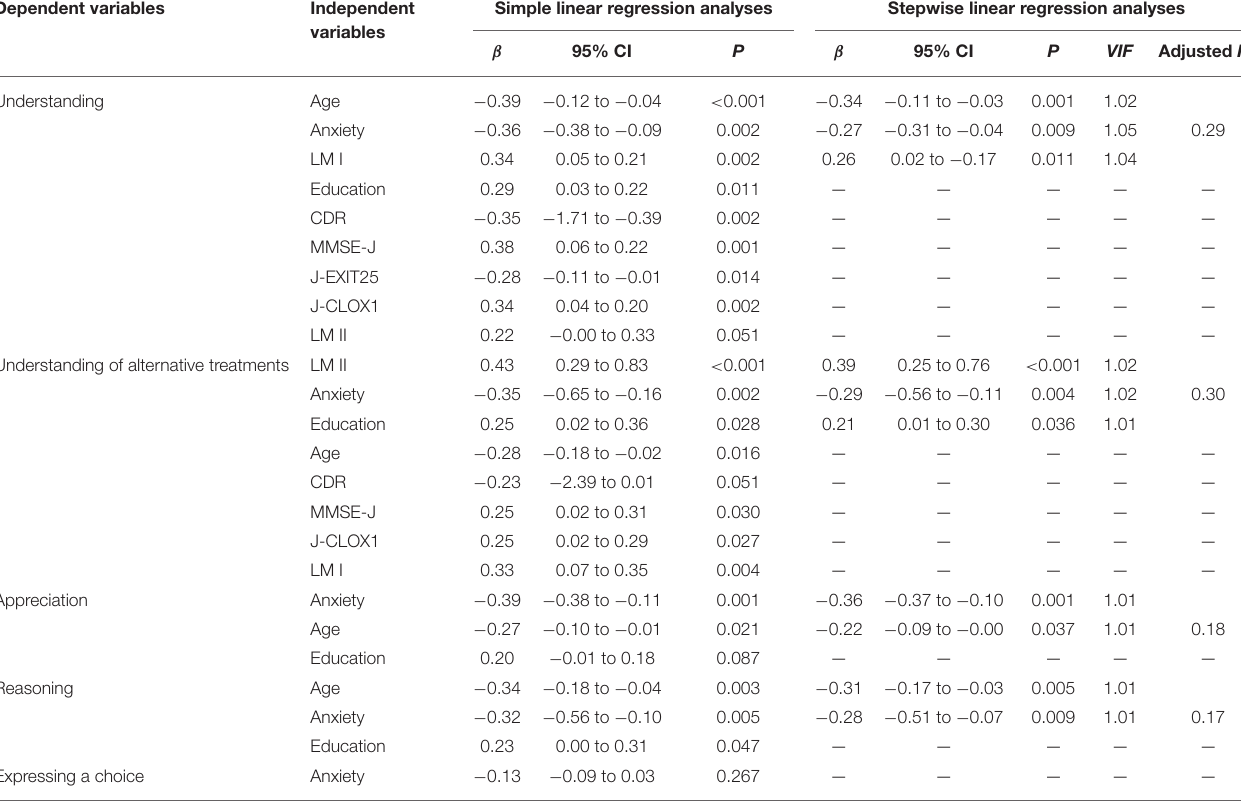
TABLE 5 | Simple linear regression and stepwise linear regression analyses with significant demographic, neuropsychological, and psychiatric variables for decision-making abilities. Dependent variables